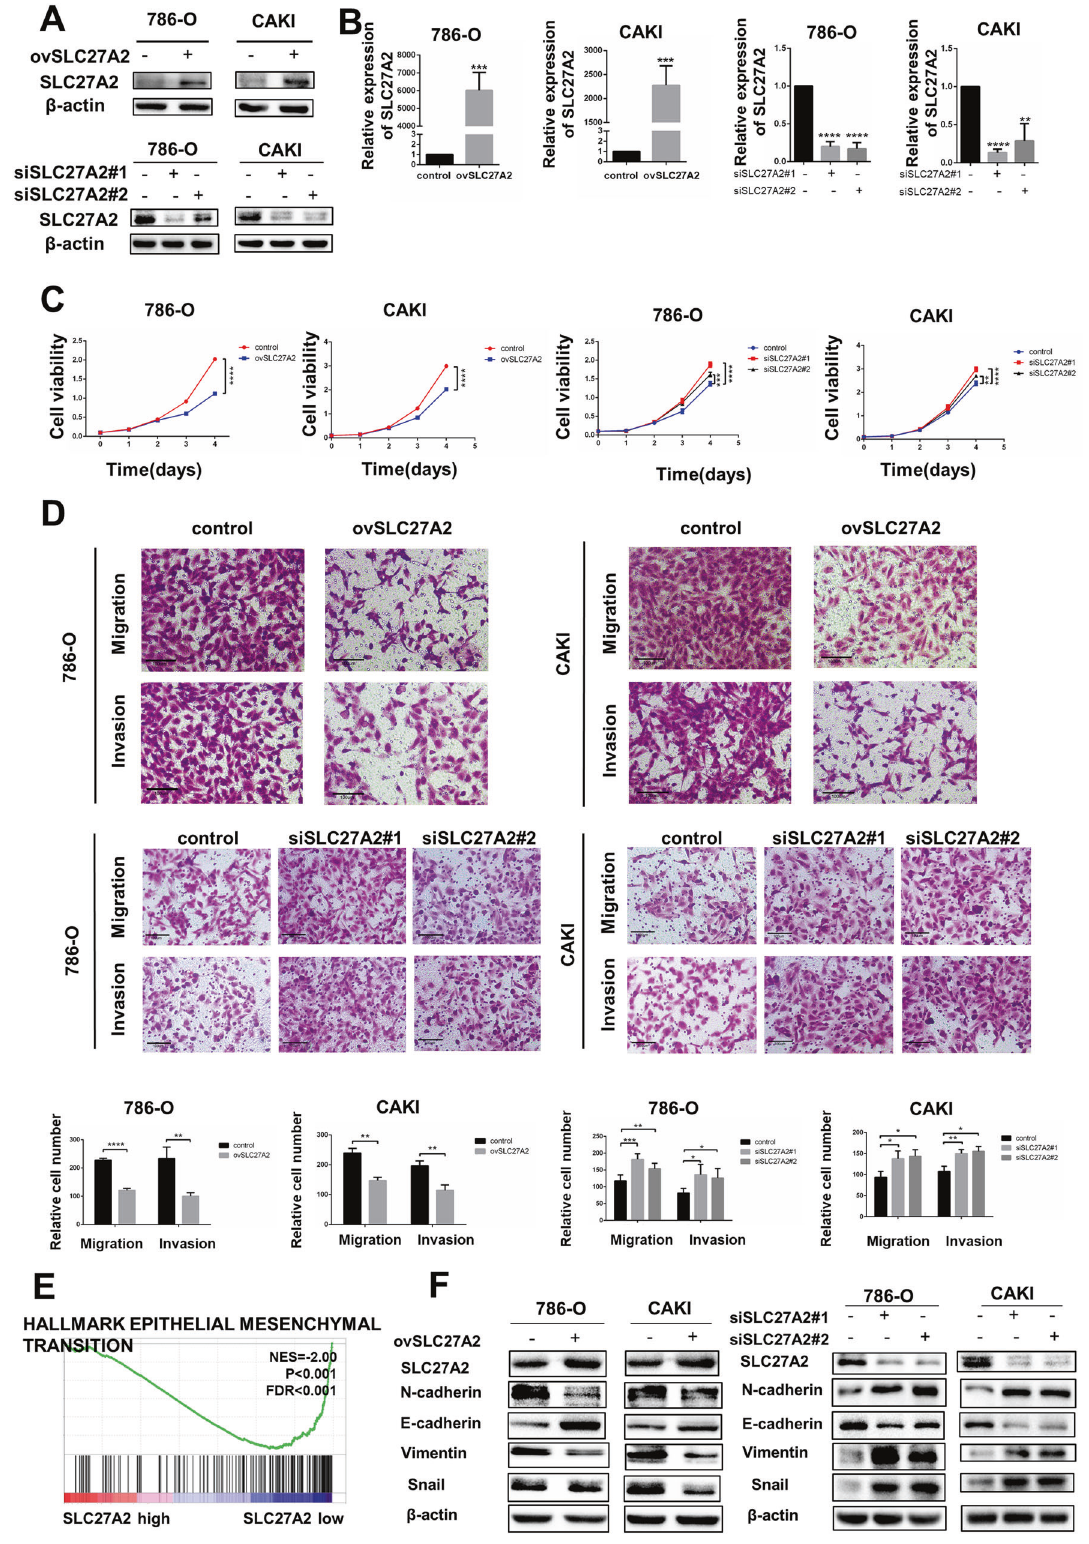
Fig. 4 SLC27A2 functioned as an anti-oncogene and inhibited metastasis and EMT in ccRCC. A , B SLC27A2 protein and mRNA expression after overexpression or knockdown. C Cell growth curves of CCK8 assay for indicated cells. D Migration and invasion assays for indicated cells (Magni fi cation: 200×). E GSEA assays for the correlation of EMT signaling pathway and mRNA level of SLC27A2 according to TCGA database. F The expression change of EMT markers in ccRCC cells with overexpressing or knockdown SLC27A2. * p < 0.5, ** p < 0.01, *** p < 0.001, and **** p <